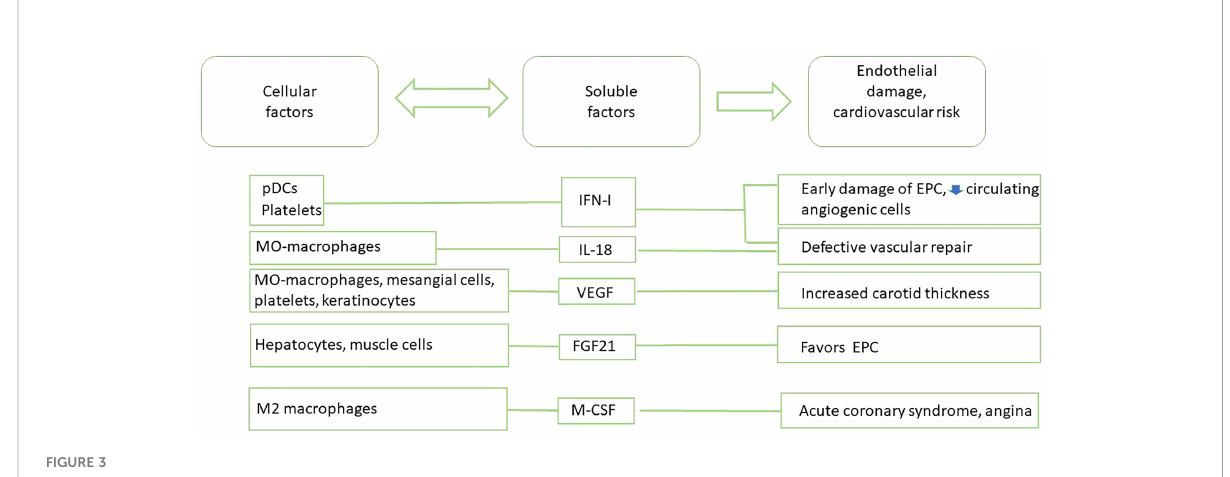
FIGURE 3 Main cytokine-based biomarkers of CVD in SLE